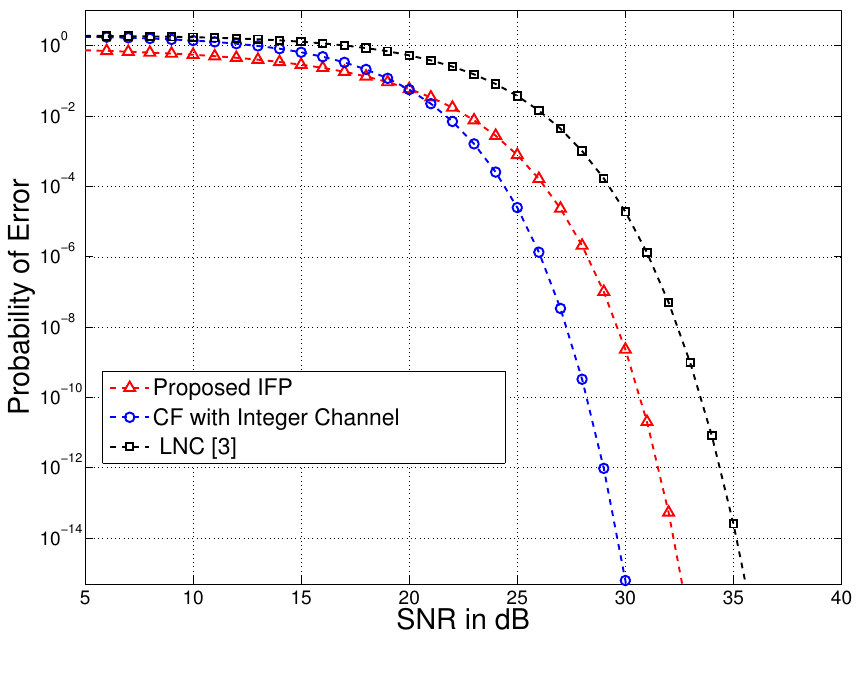
Figure 2. Comparison of the probability of error at the relay for the proposed scheme with varying signal to noise ratio (SNR) for L = 2 . The total signal power is adjusted for fair comparison with other